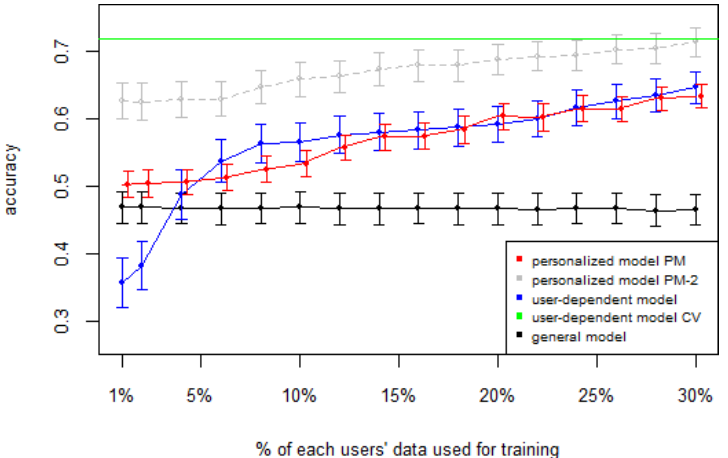
Figure 2. D2: Wrist sensor dataset. PM: Personalized Model; CV: Cross Validated.